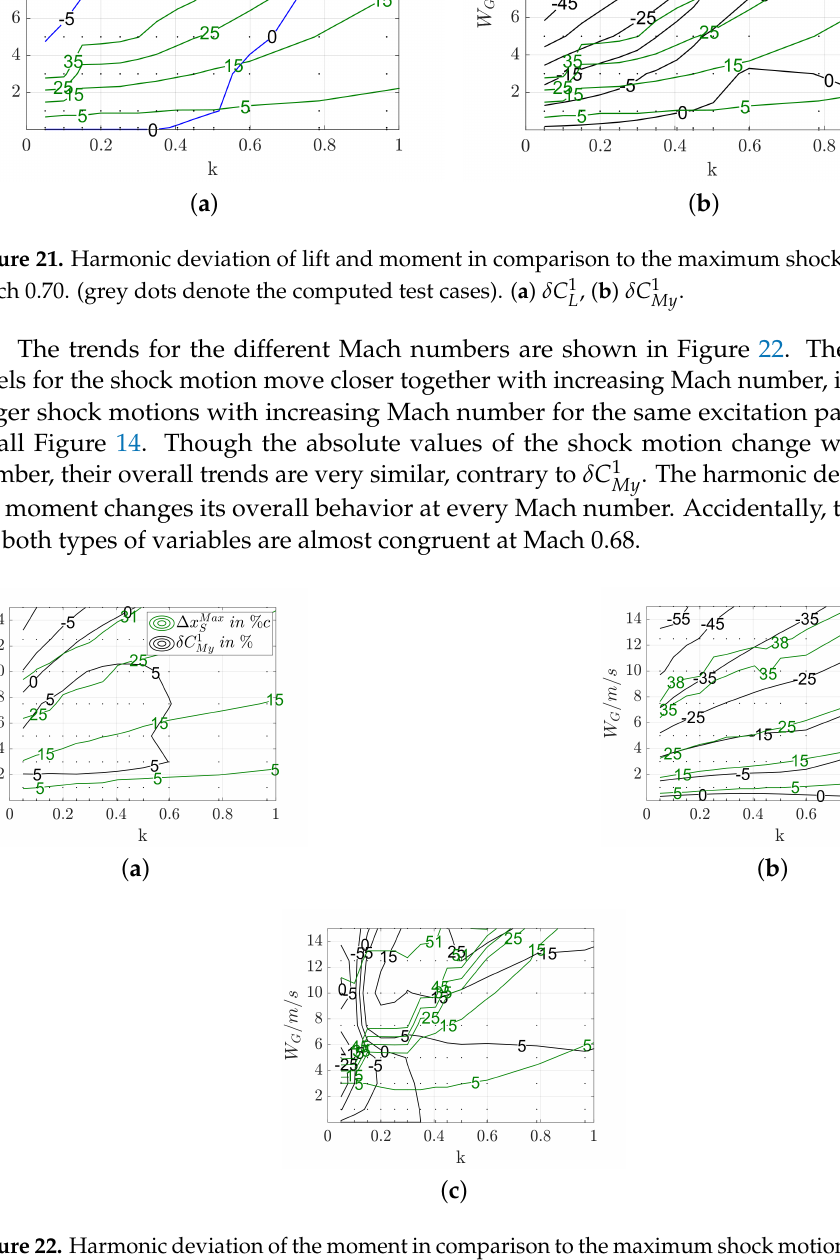
Figure 22. Harmonic deviation of the moment in comparison to the maximum shock motion. ( a ) Mach 0.66, ( b ) Mach 0.68, ( c ) Mach